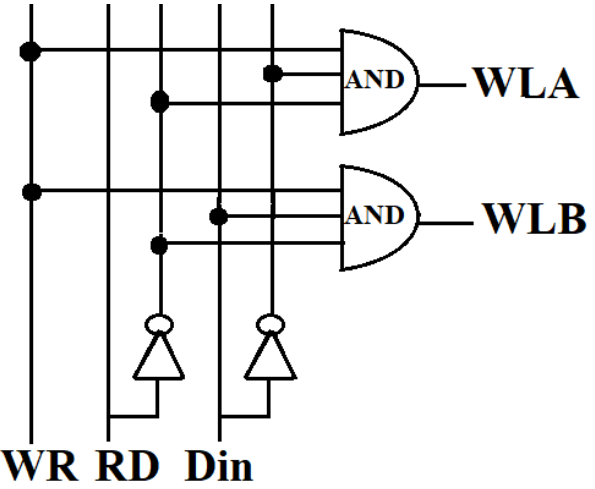
Figure 6. Word line control circuit for various modes of